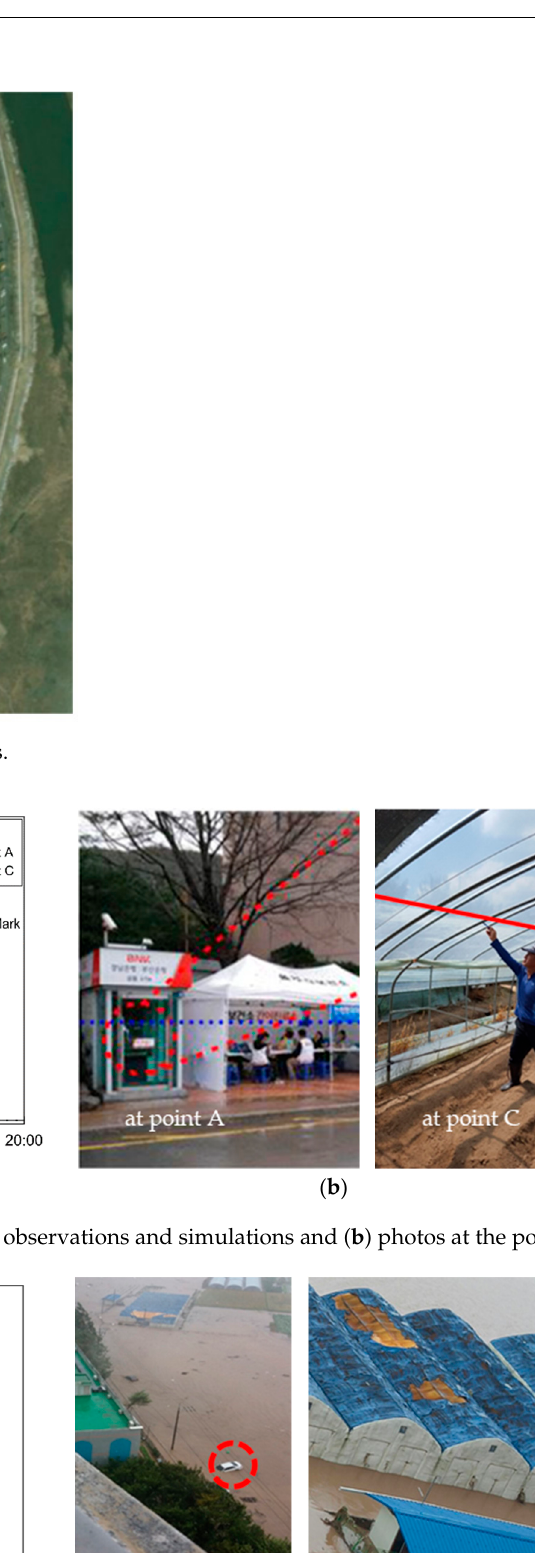
Figure 10. Flood depth at specific time: ( a ) comparison of observations and simulations ( b ) photos at the time [36]. Table 2. Comparison of observations and simulations at the points shown in Figure 8.